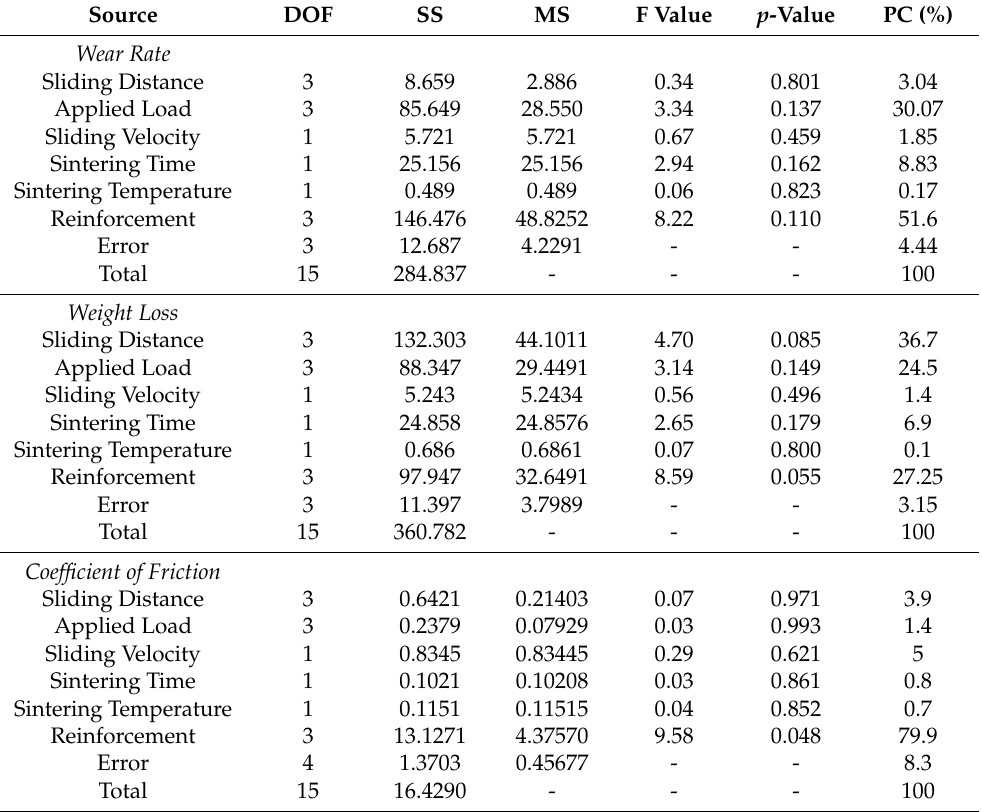
Table 3. Analysis of variance for signal-to-noise ratios of wear rate, weight loss and coefficient of